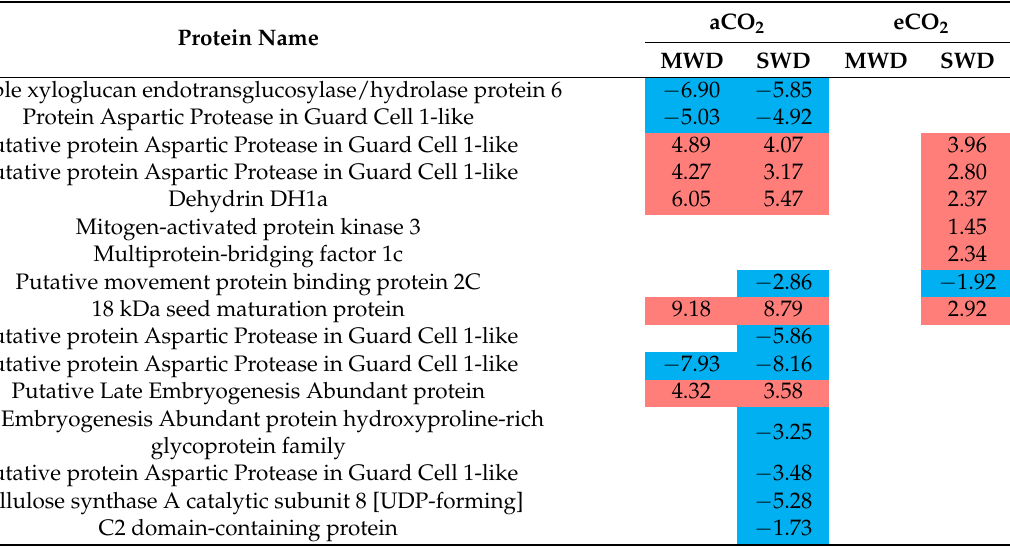
Table 2. Regulation patterns of differentially expressed genes (DEGs) related to drought responses in Coffea canephora cv. CL153 (CL153) grown under MWD or SWD in comparison with WW plants grown under ambient aCO 2 or eCO 2 , at 25/20 ◦ C (day/night). Blue: down-regulated DEGs; red: up-regulated